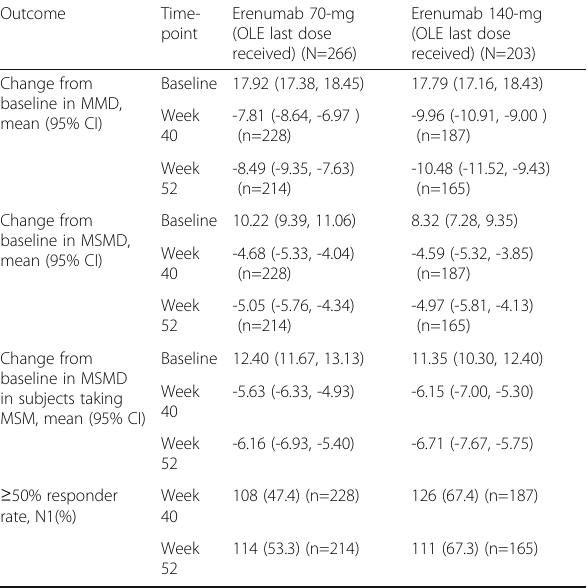
Table 2 (abstract P24). Efficacy ─ 52-week OLE completers